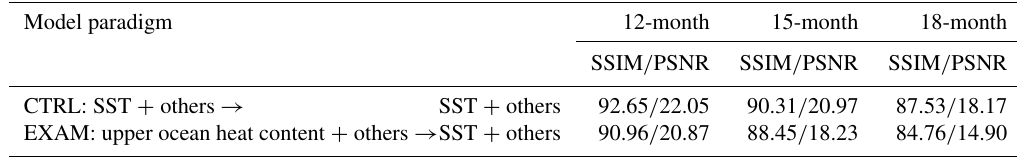
Table 4. Model performance comparison when using upper ocean heat content to replace SST in the input.